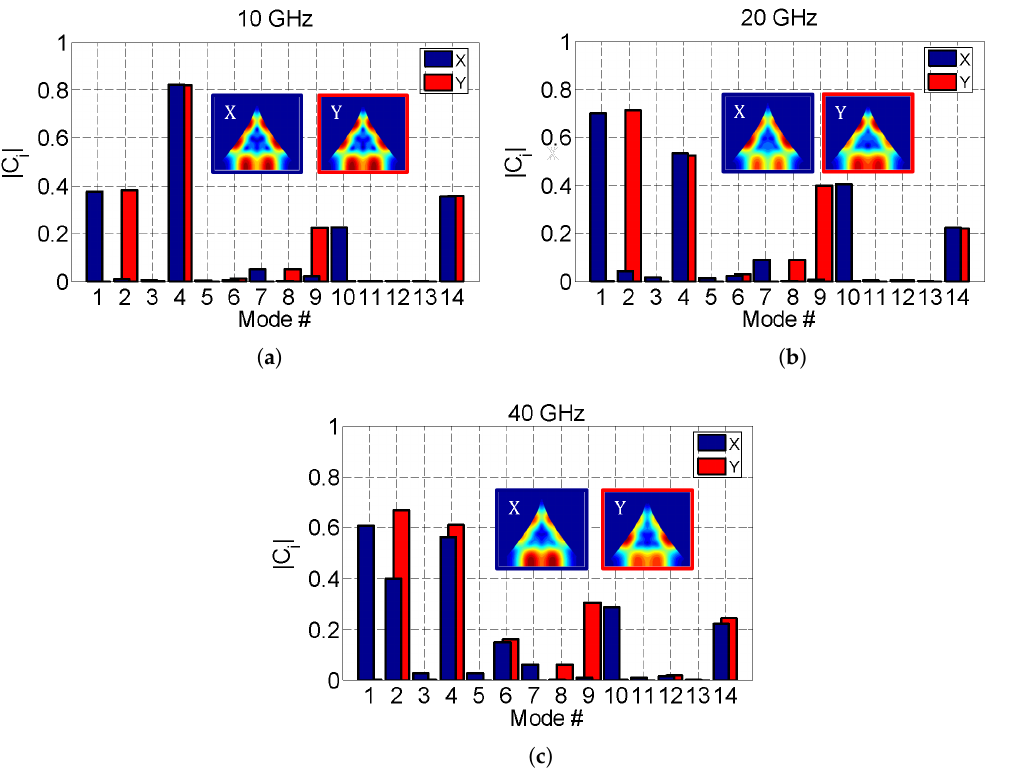
Figure 9. Normalized magnitude of the coefficients C i in the mirror-symmetric configuration for wave propagation in x and y directions at different frequencies: ( a ) 10GHz, ( b ) 20GHz, ( c )40 GHz. The normalized magnitude of the tangential electric field, calculated according to Equation (1), is also displayed for both propagating directions. The geometrical parameters of the considered unit cells are: h hole = 1.5mm, g = 0.2mm, h t = 3mm, and d x = d y = 4.5mm. The dispersion diagram of the structure is displayed in the green curve of